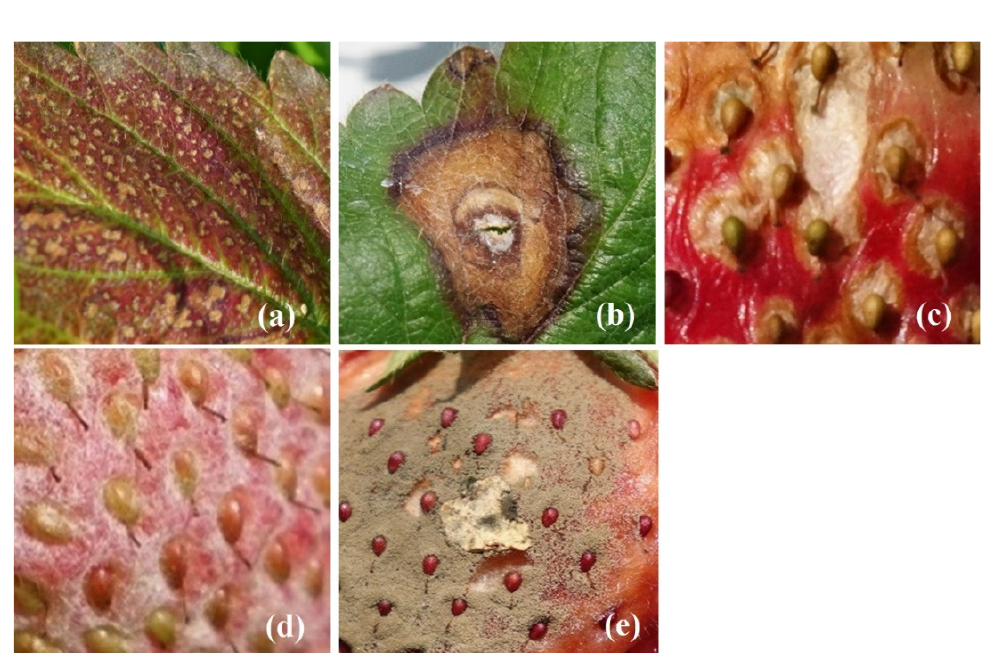
Figure 6. A total of 1306 feature images were trimmed from original images for different diseases of strawberry plant—( a ) crown rot caused by leaf blight, ( b ) leaf blight, ( c ) fruit rot caused by leaf blight, ( d ) powdery mildew, and ( e ) gray